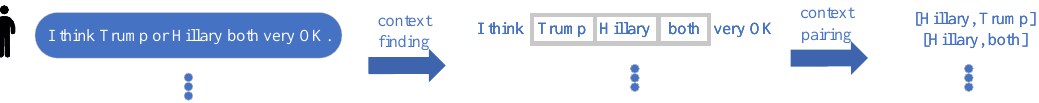
Figure 2. An illustration of Skip-Gram processing. In this example, if we choose word “ Hillary ” as the center word, the context words are “ Trump ” and “ both ”, resulting in two context-word pair entries: [ Hillary , Trump ] and [ Hillary , both ].